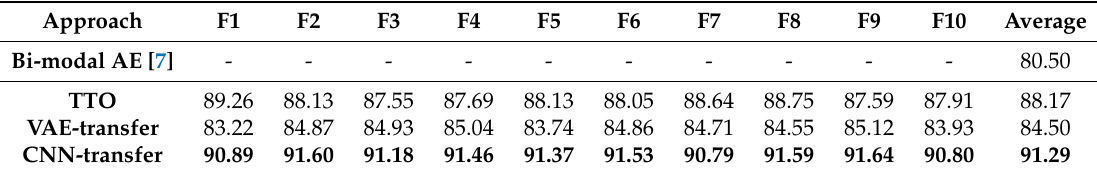
Table 7. 10-fold cross validation accuracies (in %) for the classification of AROUSAL using a multichannel DNN on the DEAP dataset. F i refers to fold number i . The best performance for each fold is highlighted in bold.